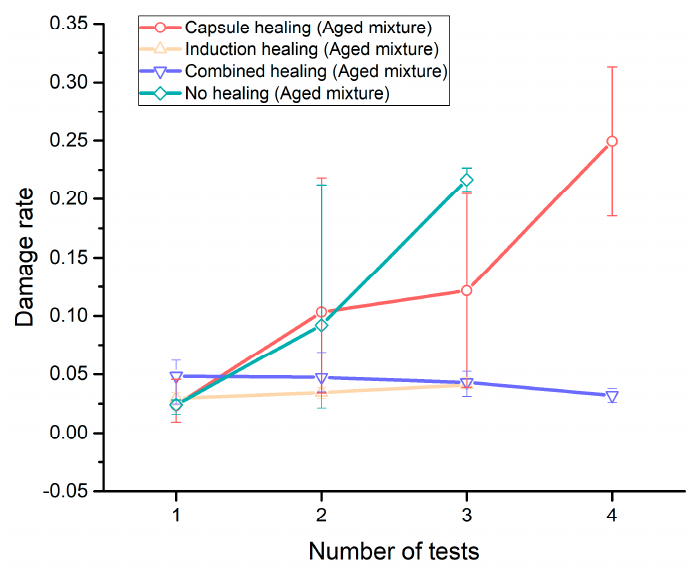
Figure 18. The damage rate acquired from each 4PB damaging and healing cycle.